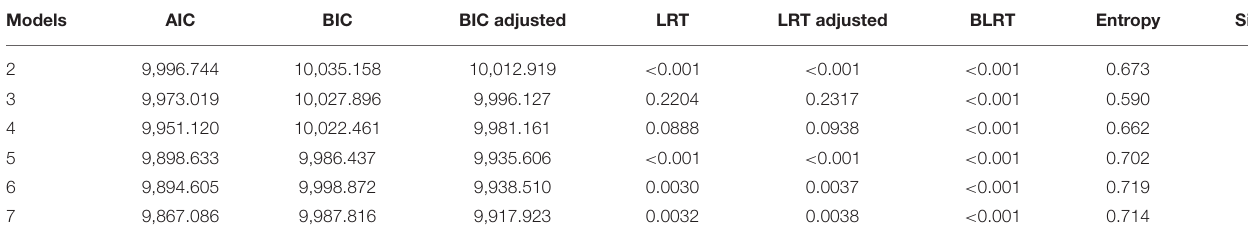
LRT, Vuong–Lo–Mendell–Rubin likelihood ratio test; BLRT, bootstrap likelihood ratio test.